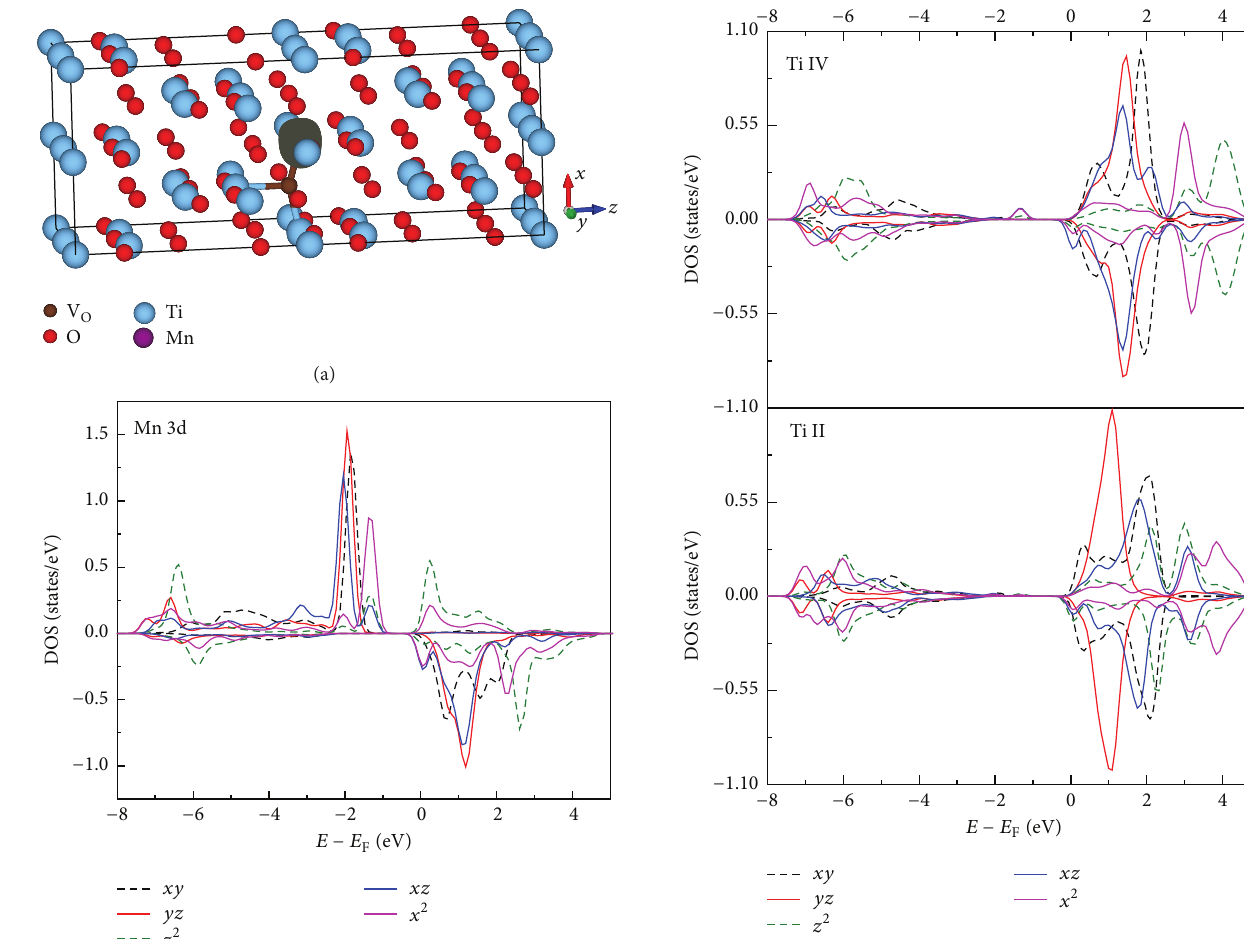
Figure 4: The orbital decomposed density of states projected on Ti II 3d electrons and Ti IV 3d electrons nearest to V O for Ti 31 MnO 63